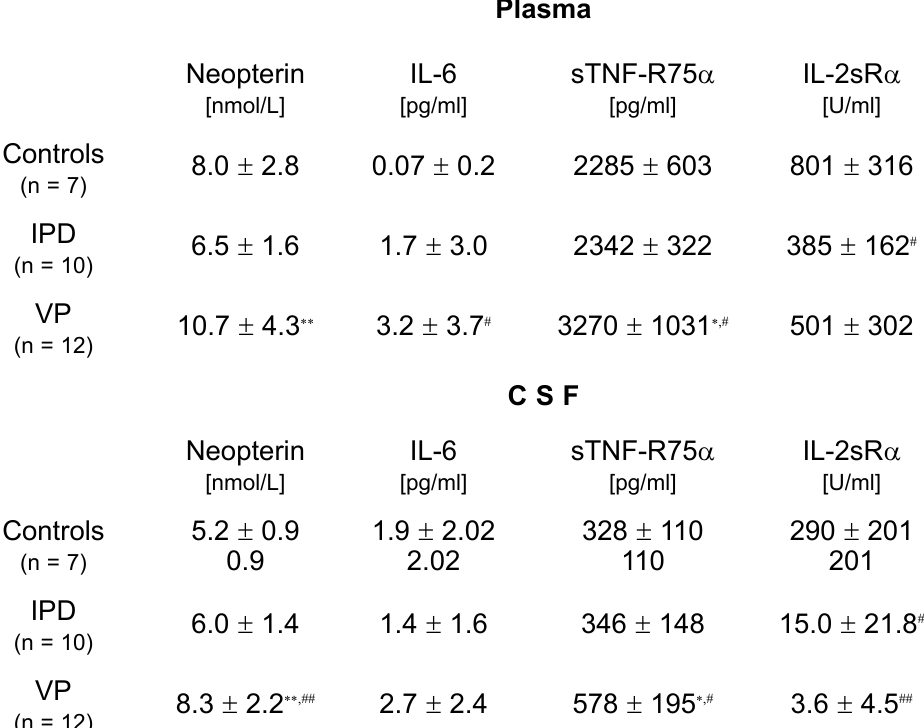
Table 2. Neopterin, interleukin-6 (IL-6), soluble 75kD tumor necrosis factor receptor- α (sTNF-R75 α ) and inter- leukin 2 soluble receptor- α (IL-2sR α ) concentrations in plasma and CSF of controls, patients with idiopathic Parkinson's disease (IPD) and vascular parkinsonism (VP) (mean values ± S.D. are given; ∗ p < 0.05 and ∗∗ p < 0.01 compared VP vs. IPD, # p < 0.05 and ## p < 0.01 compared to